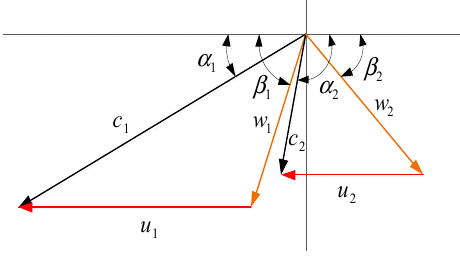
Figure 4. Velocity triangle of the radial-flow turbine.